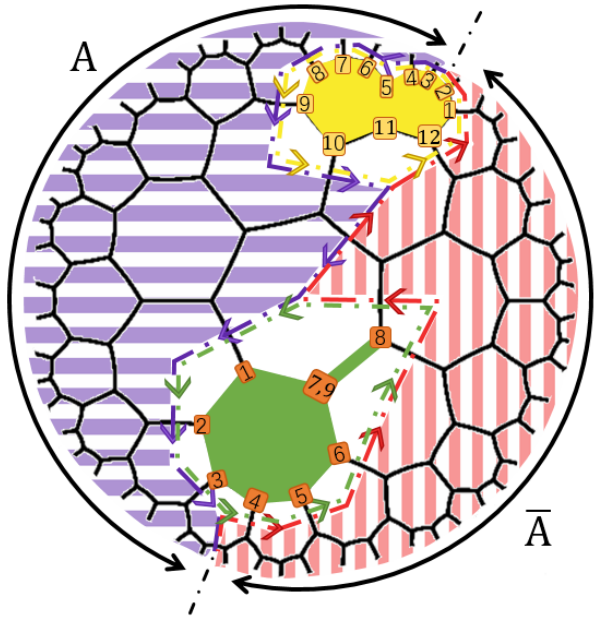
(red) consists of two A